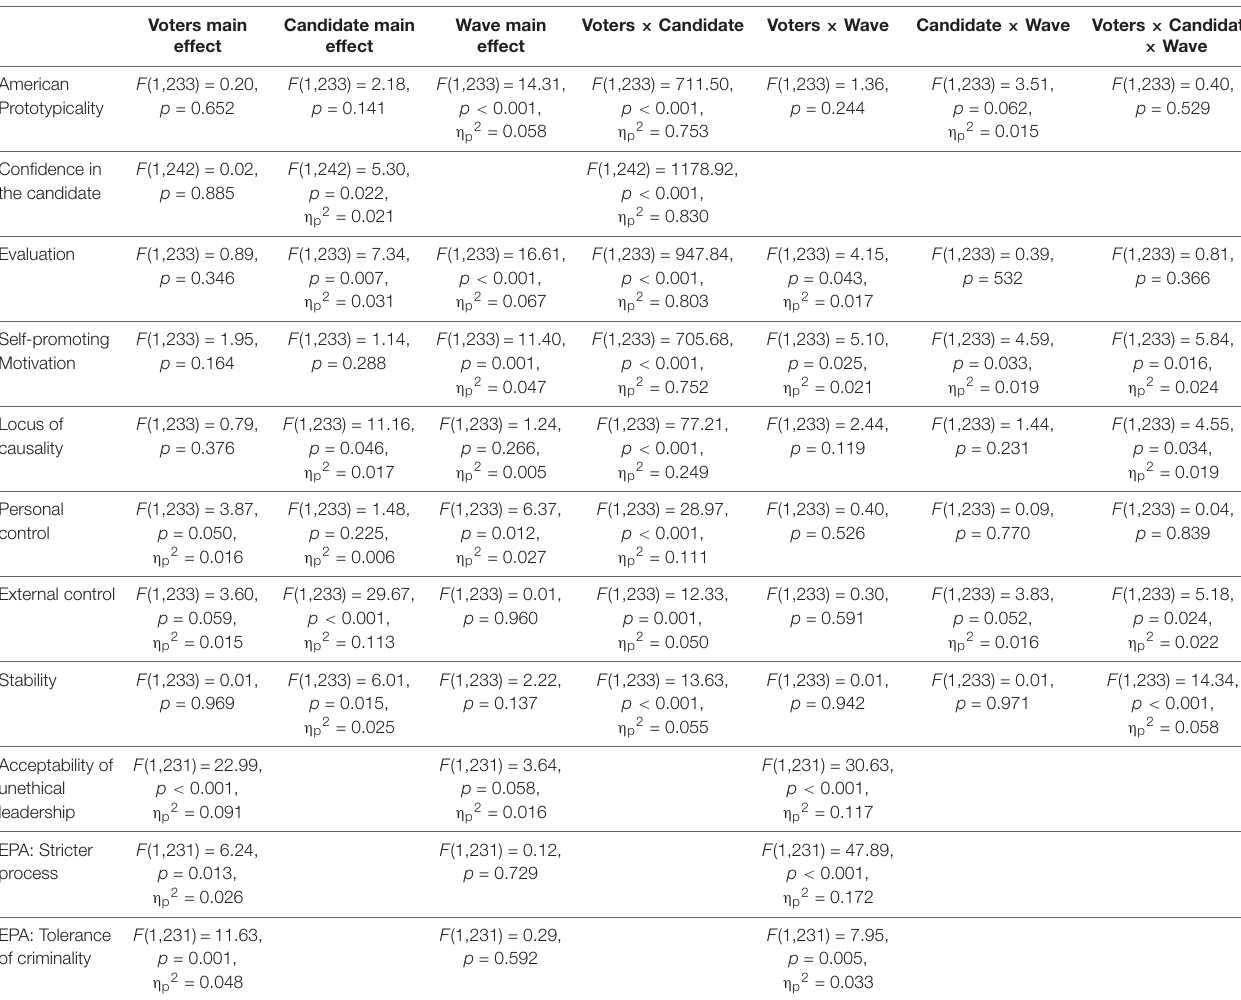
TABLE 2 | ANOVA results for all variables without covariates